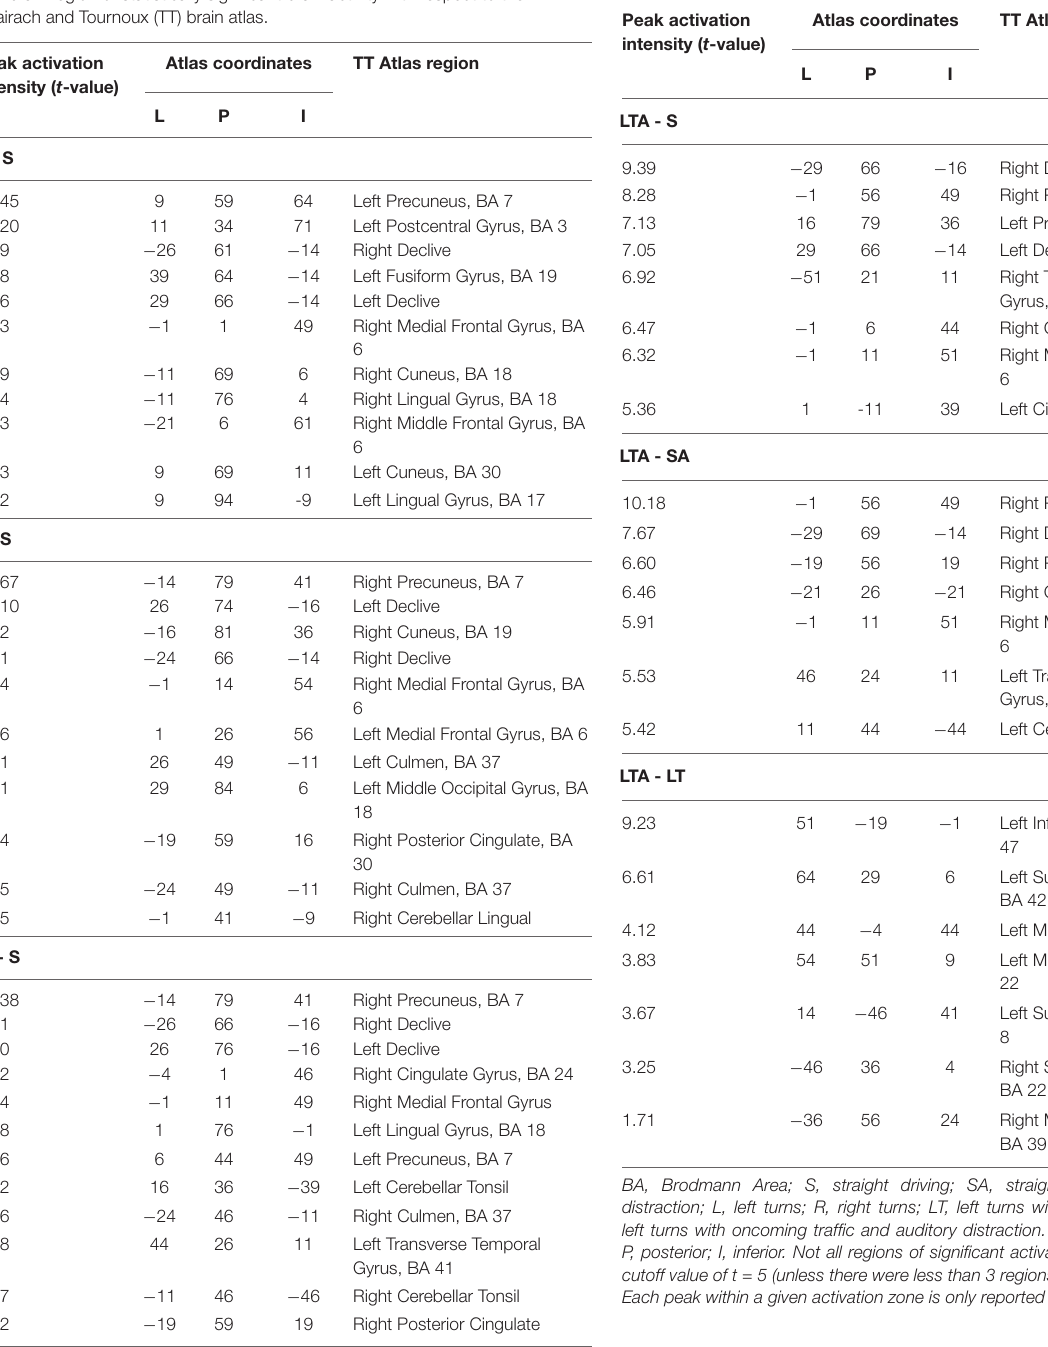
scatter plots showing the change scores for the mean BOLD signal intensity and blink rate (L – LT, LTA – LT) showed negative, statistically significant Pearson correlations in the insula [mean slope of − 0.13 (0.05)], middle frontal [ − 0.01 (0.04)] and superior temporal [ − 0.03 (0.07)] regions, as shown in Figure 7 . A positive, statistically significant Pearson correlation was found in the middle occipital gyrus [0.02